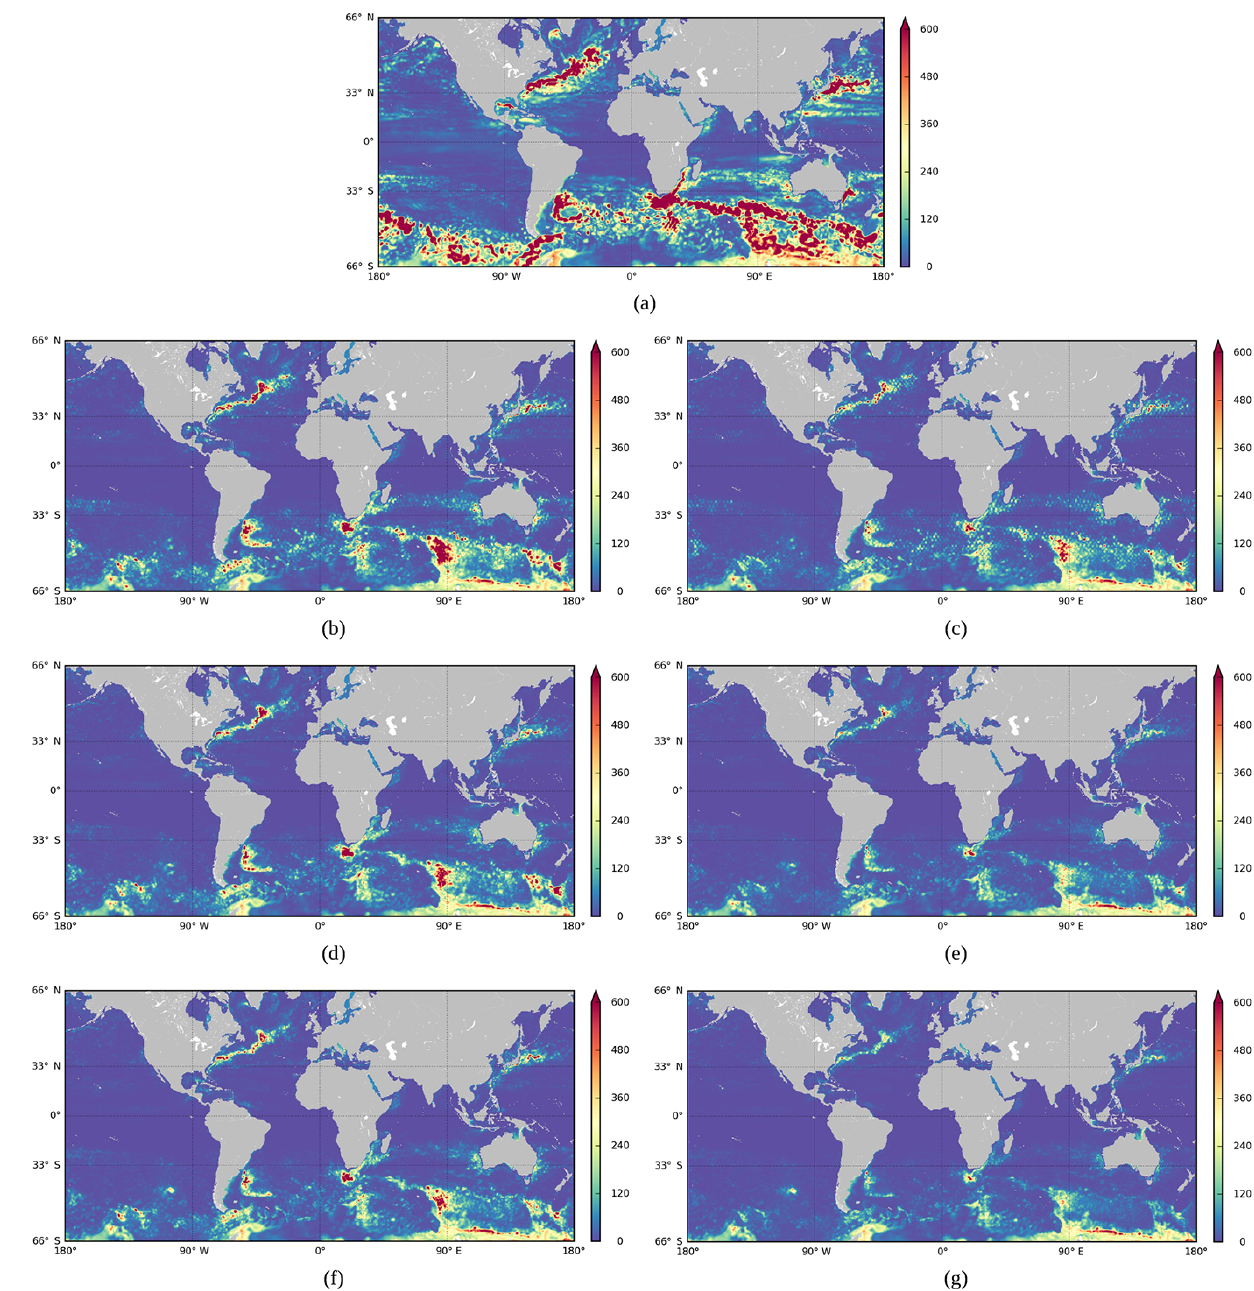
Figure 2. Global mean square error (MSE) of the relative SL in cm 2 compared to NR for the FR (a) , Sat1 (b, c) , Sat2 (d, e) and Sat3 (f, g) . Seven-day forecasts in the left column and analyses in the right over the June–December 2009